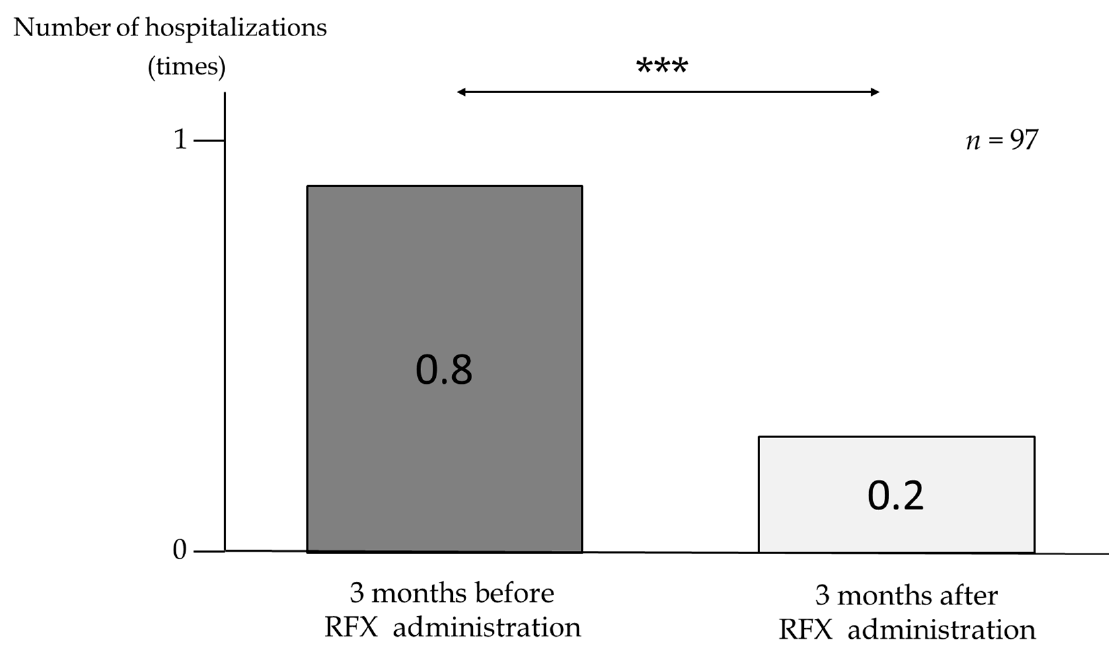
Figure 7. Number of hospitalizations due to liver-related events included for hepatic ascites and hepatic encephalopathy ( n = 97) 3 months before and after RFX administration. p -values were determined using the Mann–Whitney U test ( p < 0.001 ***). n , number; RFX, rifaximin.